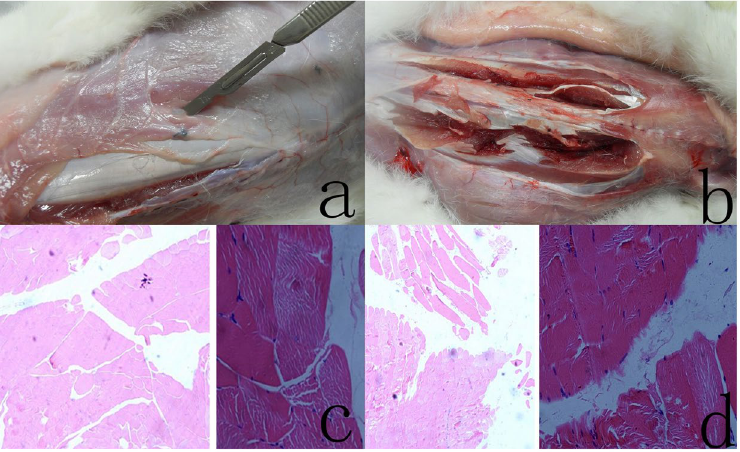
Figure 4. ( a ) The SF/PU hydrogel implanted for 3 months. The hydrogel is encapsulated in the muscle tissue of New Zealand white rabbits. After 3 months, the hydrogel is clear which can be seen at the center of the muscle tissue (beside the blade). The implanted SF/PU hydrogel maintained its shape at the implanted site for the full experimental observation period. the implants has not changed in visual appearance or dimensions after 3 months. ( b ) Animals were sacrificed at 12th week postoperatively; View of the muscle of the New Zealand white rabbit paravertebral muscles on left and right side of the spine. No inflammatory response was observed in the muscle. Neither infection signs nor pus formation was noticed grossly. ( c ) Microscopic appearance of the muscle of New Zealand white rabbit in the blank control groups. No inflammatory response was observed in the muscle. H & E stain, original magnification × 4 and × 20. ( d ) Microscopic appearance of the muscle of New Zealand white rabbits surrounding an implanted SF/PU hydrogel sample after 3 months. No minimal inflammatory response was observed in the surrounding muscle. H & E stain, original magnification × 4 and ×